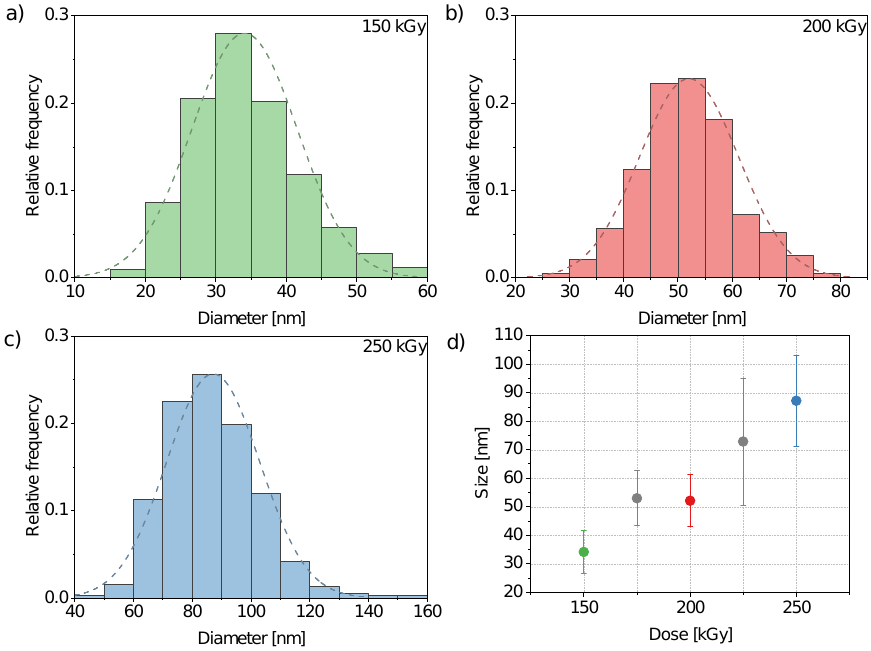
Figure 4. Cluster size distribution with normal distribution fit (dashed line) at ( a ) 150kGy, ( b ) 200kGy and ( c ) 250kGy and ( d ) cluster size depending on irradiation dose